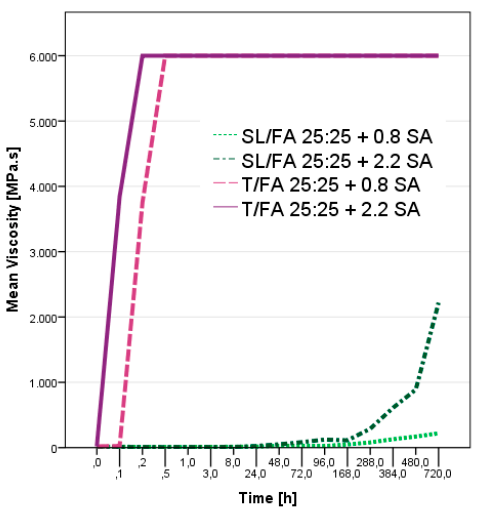
Figure 2. Viscosity behavior of spent-liquor/FA and tannin/FA formulations after addition of different amount of sulfuric acid (SA) as hardener.